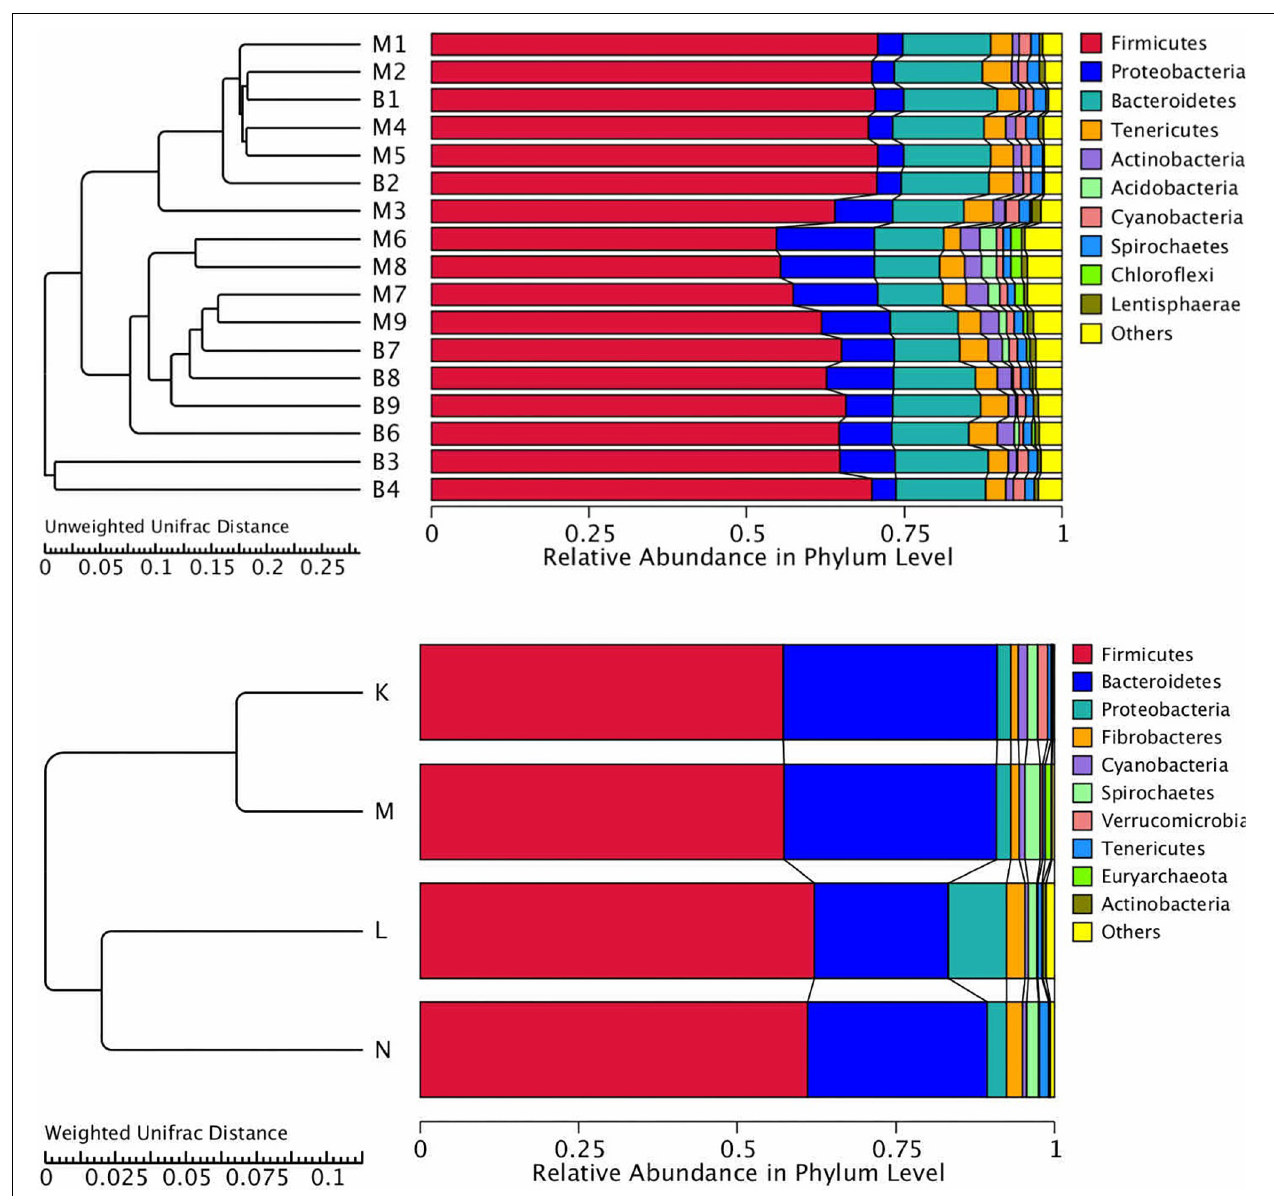
FIGURE 4 | Cluster analysis with the Unifracdistance matrix. The top figure is based on the unweighted Unifrac distance and the clustering in groups. The bottom figure is based on the weighted Unifrac distance. K, low-altitude mouflon; L, high-altitude mouflon; M, low-altitude blue sheep; N, high-altitude blue